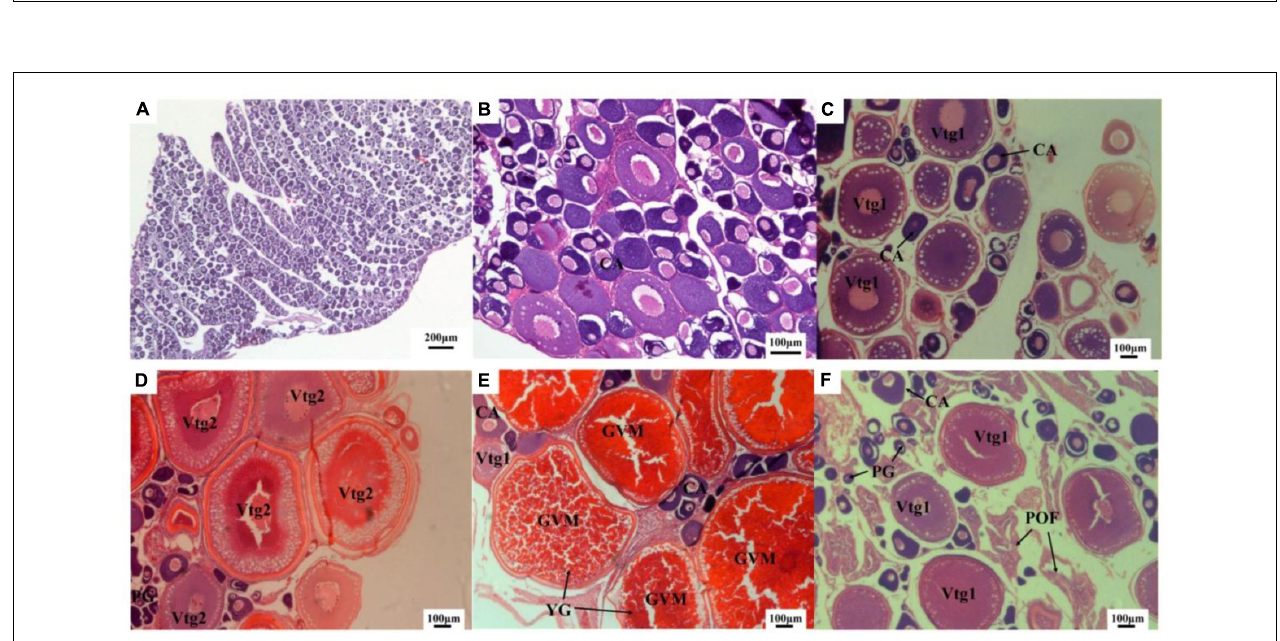
FIGURE 4 | Transverse sections of ovary of the black Amur bream (A,B) immature female ovary; (C) developing female ovary; (D) maturing female ovary; (E) mature female ovary; (F) spawning and post-spawning female ovary; CA, cortical alveolar oocyte; GVM, germinal vesicle migration; PG, primary growth oocyte; POF, post-ovulatory follicle; Vtg1, primary vitellogenic oocyte; Vtg2, secondary vitellogenic oocyte.